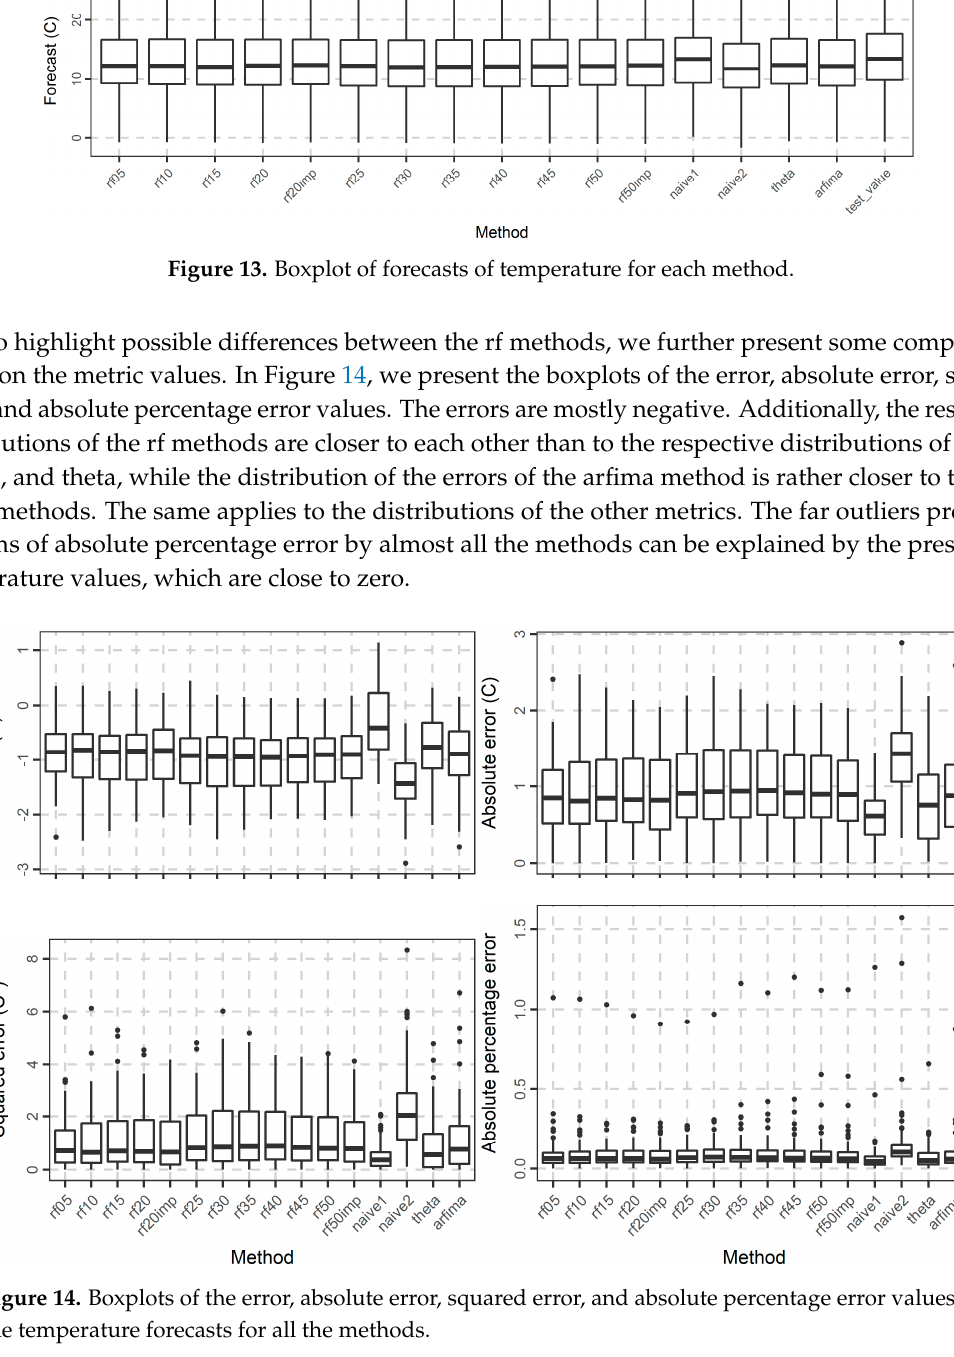
Figure 12. Ranking of methods in each simulation experiment based on the regression coefficients. Better methods are presented with lower ranking value and blue colours.